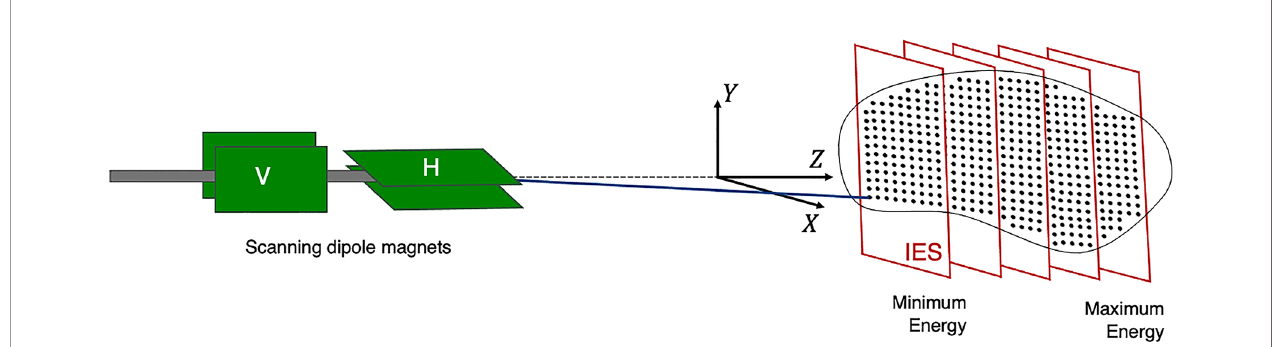
FIGURE 3 | Active PBS. The BDS delivers a conformal dose distribution to the treatment volume by scanning the beam along a calculated path in the transverse plane. The beam energy is then adjusted to change the depth (typically lower in energy), switching to a proximal IES, scanning through subsequent layers.